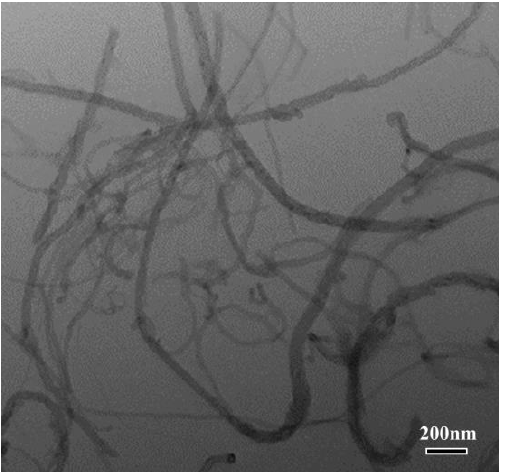
Figure 1. TEM micrograph of MWCNTs used in this work.